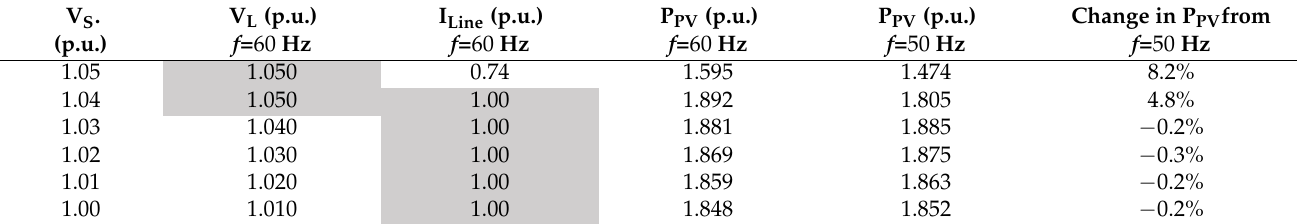
Table 7. Effect of system frequency on maximum PV penetration limit for the OHL.